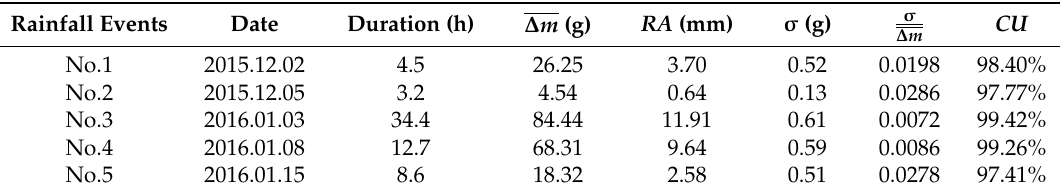
Table 1. Uniformity test results of five natural occurring rainfall events with the scale of 2.2 m × 2.2 m. ∆ m corresponds to the average rain weight of all 144 measuring points and σ refers to the standard deviation of the referred